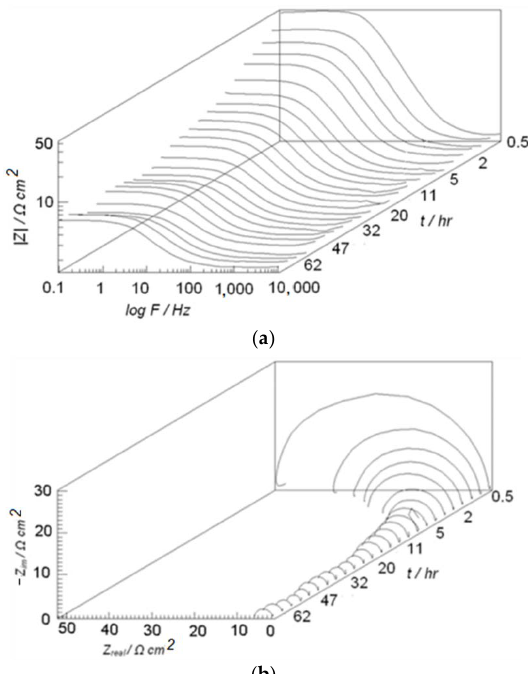
Figure 9. ( a ) Bode impedance, ( b ) Nyquist plots of CoNiCrAlY in 0.5 M sulfuric acid for a period of 72 h with a time interval of 0.5 to 5